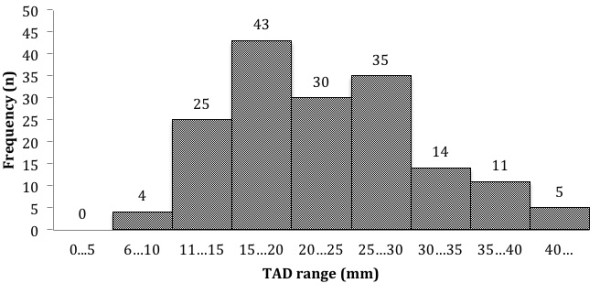
TAD distribution.